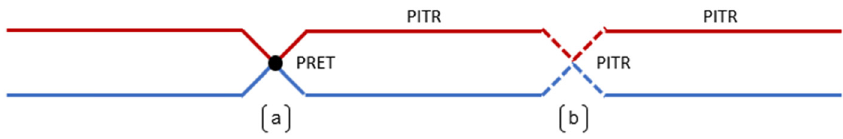
Figure 4: Di ff erent conditions when the dimensions converge to intersect. In the fi gure, ( a ) signi fi es liminality and ( b ) signi fi es sustained